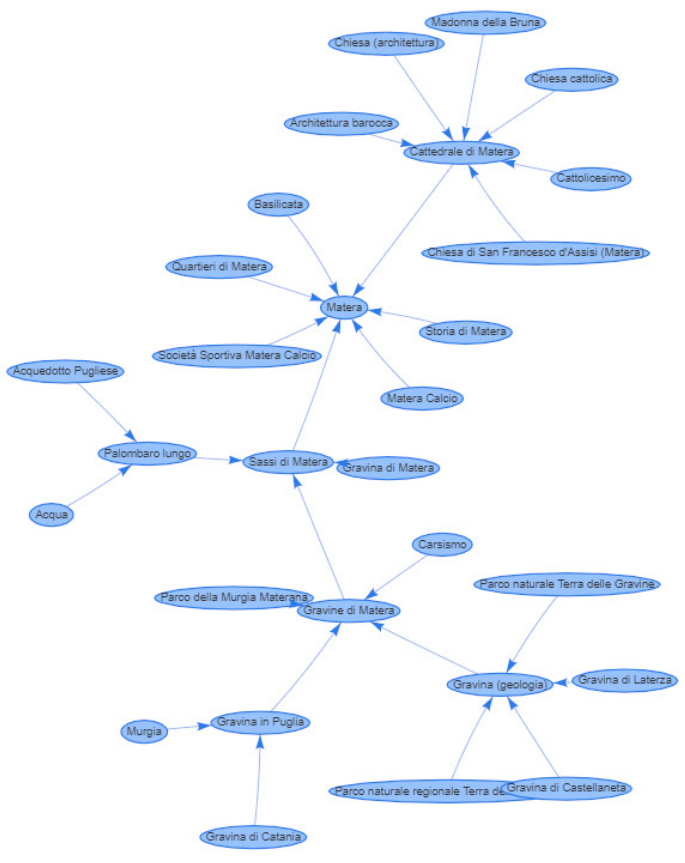
Figure 7. A graphical representation of the related topics graph written thanks to the help of the suggestions proposed by the W IKI TEL system.